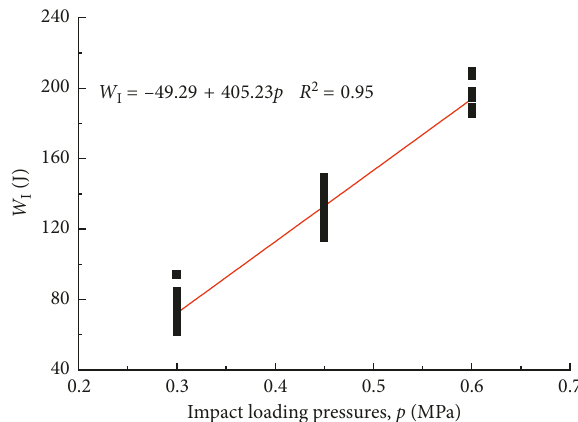
Figure 4: Relation between impact loading pressures and incident